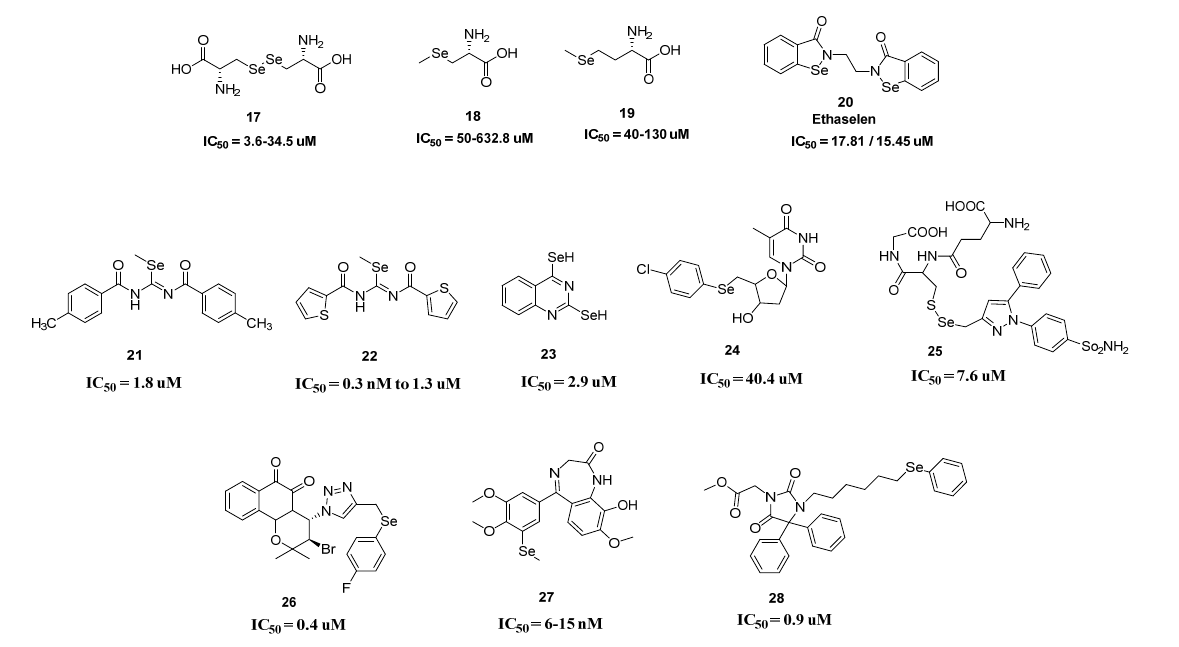
Figure 2. Structural representation of peptide-based selenium-containing compounds ( 17 – 19 ) [56–60], ethaselen ( 20 ) [62], and selenides ( 21 – 28 ) [65–72] for anticancer activity and corresponding IC 50